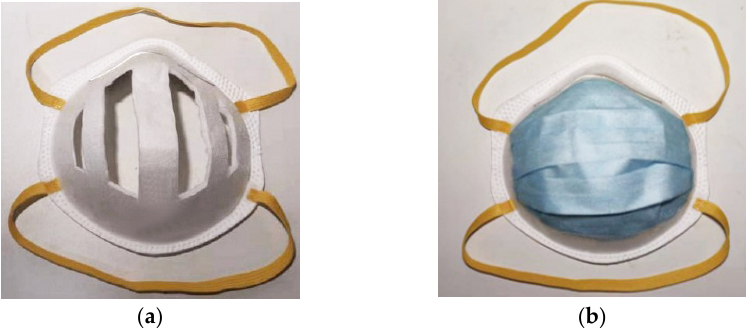
Figure 1. The modified face mask: ( a ) the mask frame, ( b ) the appearance of a modified mask.